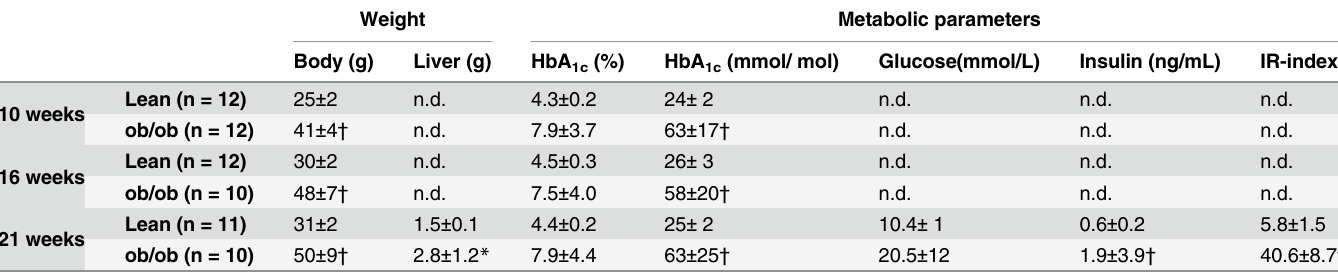
Table 1. Weight data and metabolic parameters in 10, 16 and 21 weeks old lean controls and leptin-deficient (ob/ob) mice.